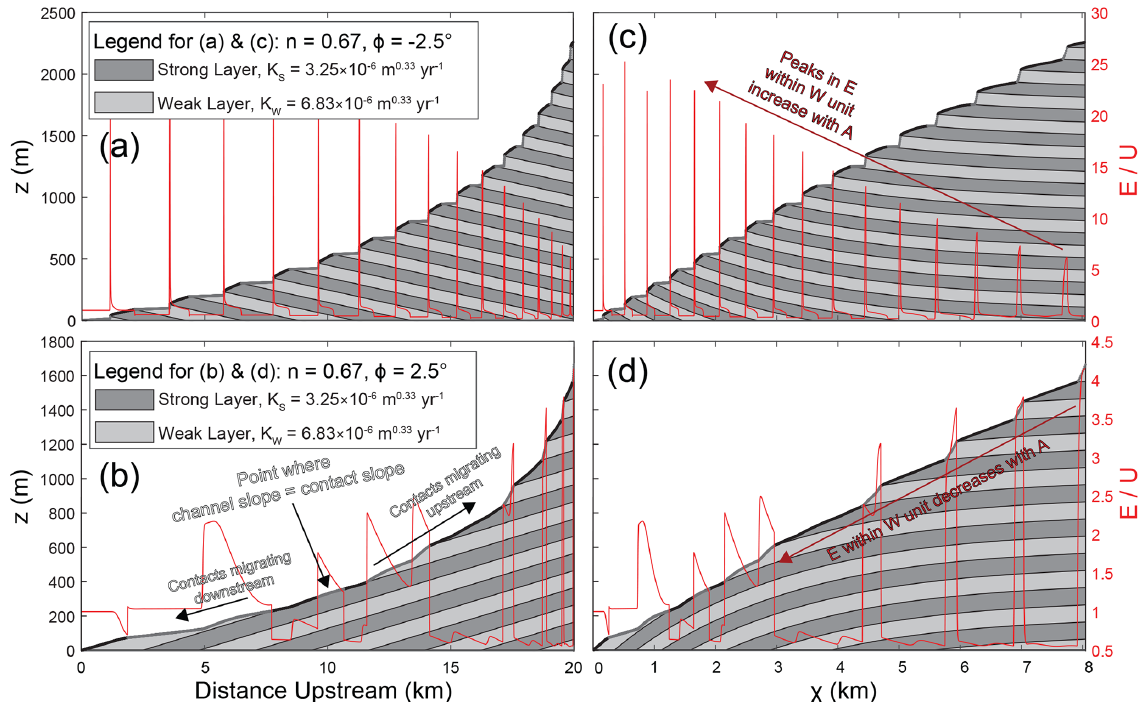
Figure 7. Longitudinal profiles (a, b) and χ plots (c, d) for two different simulations with n = 0 . 67. The simulation in (a) and (c) has contact dip φ = − 2 . 5 ◦ , while the simulation in (b) and (d) has φ = 2 . 5 ◦ . Layer thickness H and rock-uplift rate U are 100m and 0.15mmyr − 1 in both simulations,